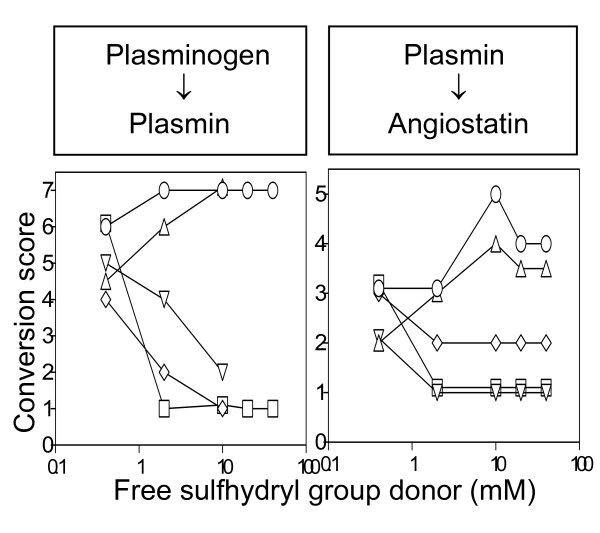
Example of in vitro angiostatin generation by tissue-type plasminogen activator and FSDs. A mixture of murine serum, tPA (2 μg/ml) and a FSD (D-penicillamine, L-cysteine, N-acetyl-L-cysteine (NAC), reduced glutathione, or captopril) was incubated for 0, 2, 4.5 or 20 hours. Conversion of plasminogen to plasmin (left panel) and plasmin to angiostatin (right panel) were scored separately on a semi-quantitative scale. D-penicillamine was the most effective FSD for generation of plasmin and angiostatin. : D-penicillamine;  : L-cysteine;  : N-acetyl L-ysteine;  : reduced glutathione;  : captopril.